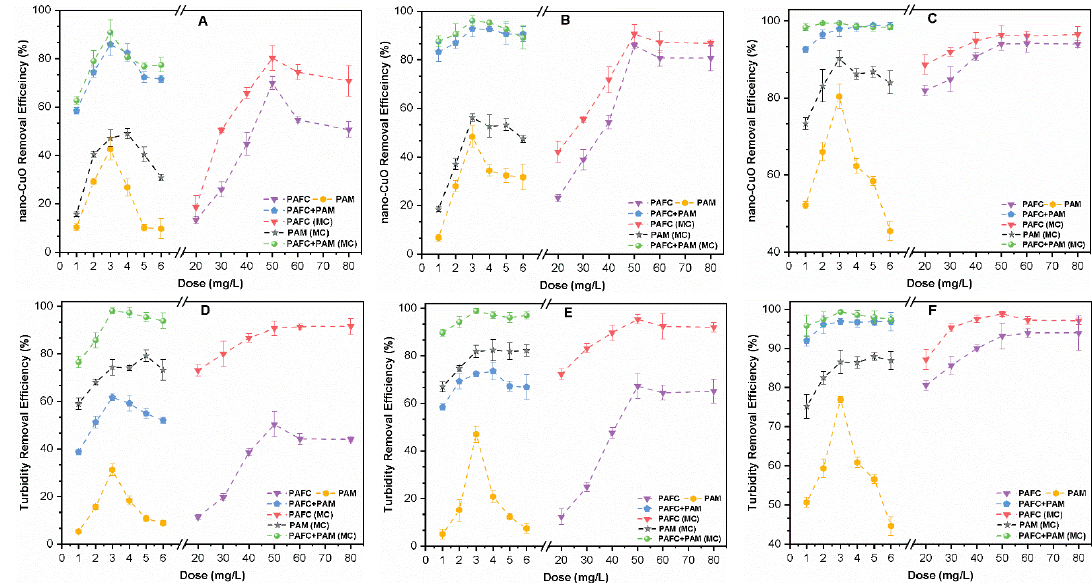
Figure 1. Influence of coagulant and flocculant dosage on the removal efficiency of nano-CuO and turbidity for various mass concentrations ( A , D ) 1 mg/L, ( B , E ) 2.5 mg/L and ( C , F ) 10 mg/L, respectively.